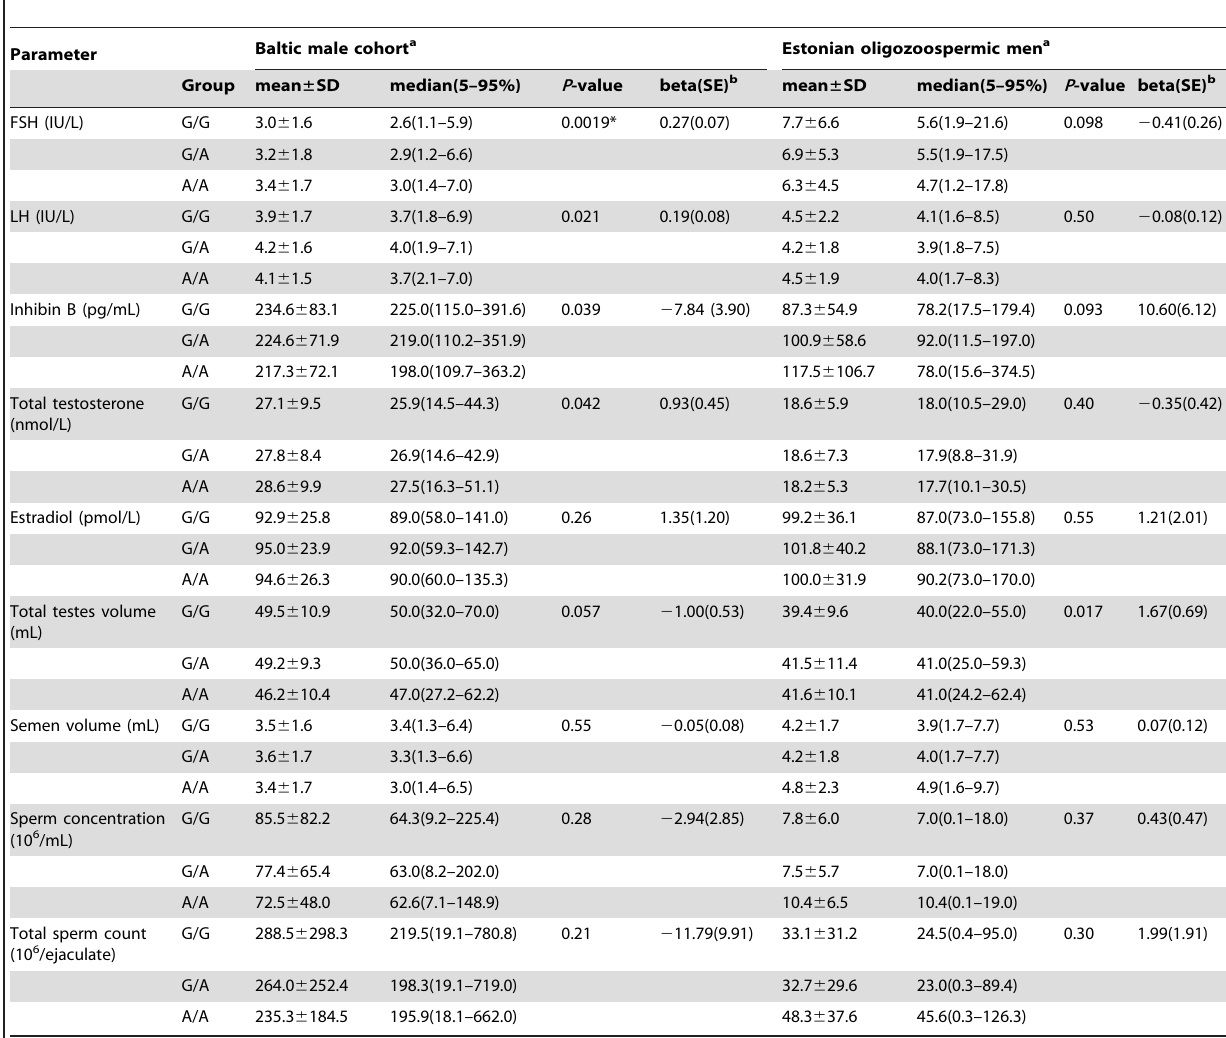
Table 2. Marker-trait association analysis and clinical parameters of the two study samples stratified into subgroups based on the FSHR -29G/A (rs1394205) genotypes of the